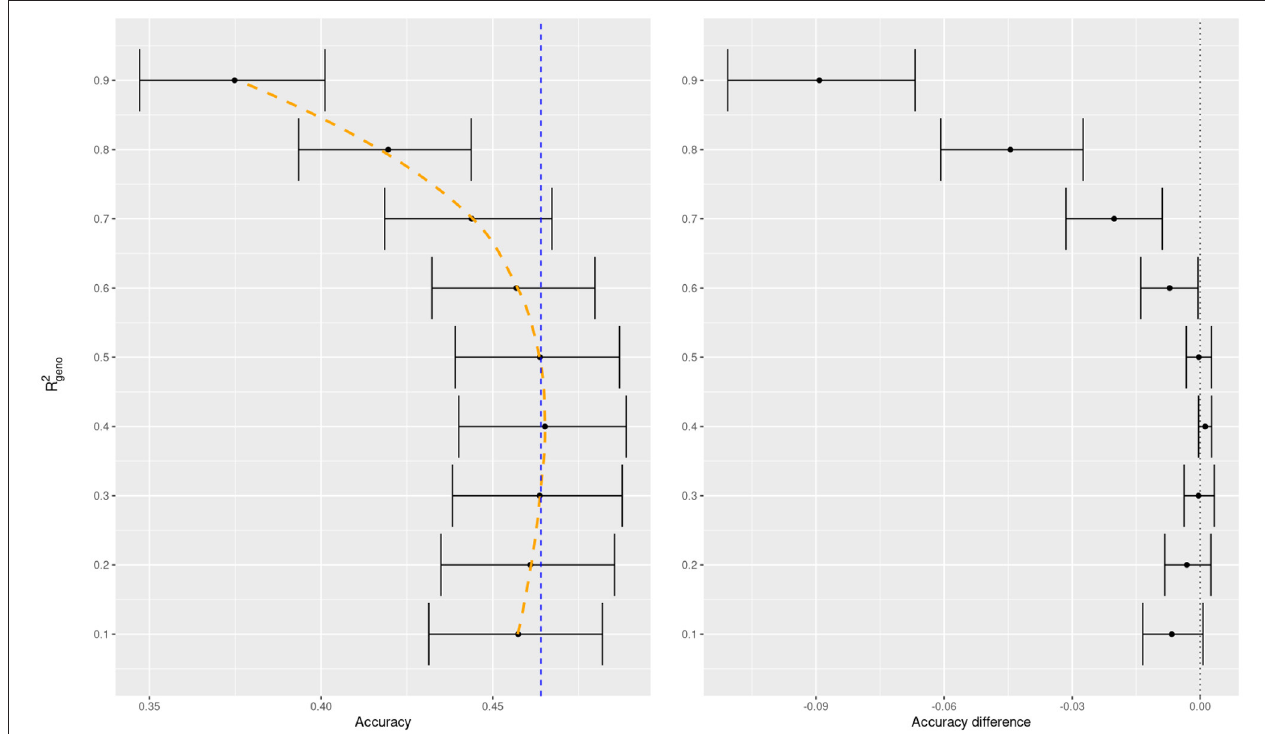
FIGURE 3 | BayesA predictive accuracy as function of prior mean of R 2 geno for trait 1 of the wheat dataset. Average predictive accuracy of the default model in BGLR (a weakly-informative prior for R 2 geno ) in dashed blue for the left panel. All accuracy differences in the right panel are taken with respect to the default model.